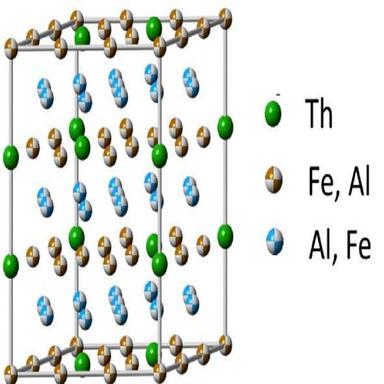
Crystallographic model of Al9Fe7Th2 (Si not explicitly shown).